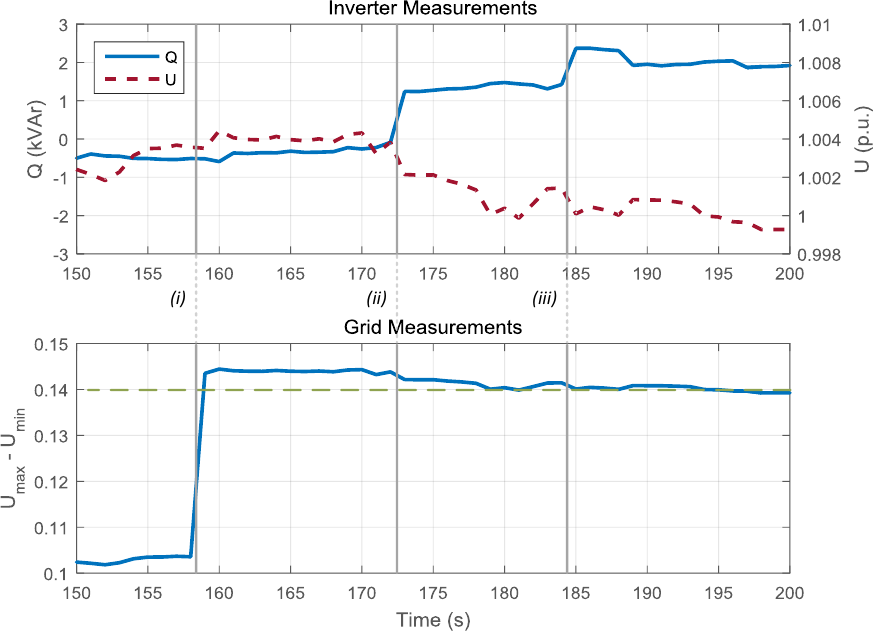
Figure 15. Measurements from the laboratory validation with three main events: (i) detection of voltage band violation, (ii) first curve correction, and (iii) second curve